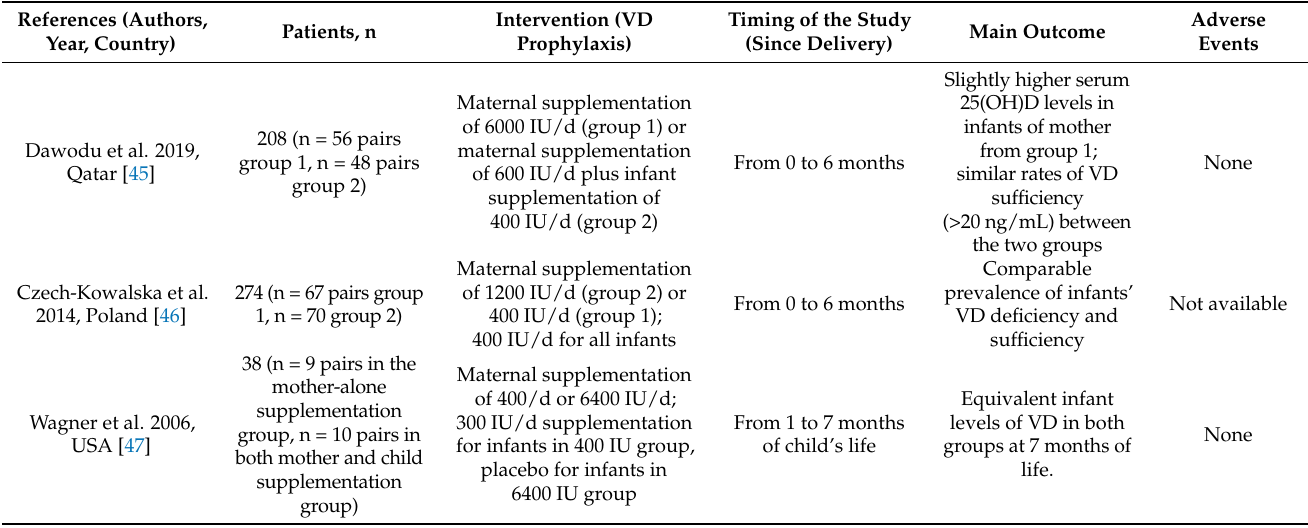
Table 3. Studies investigating Vitamin D supplementation for both mother and